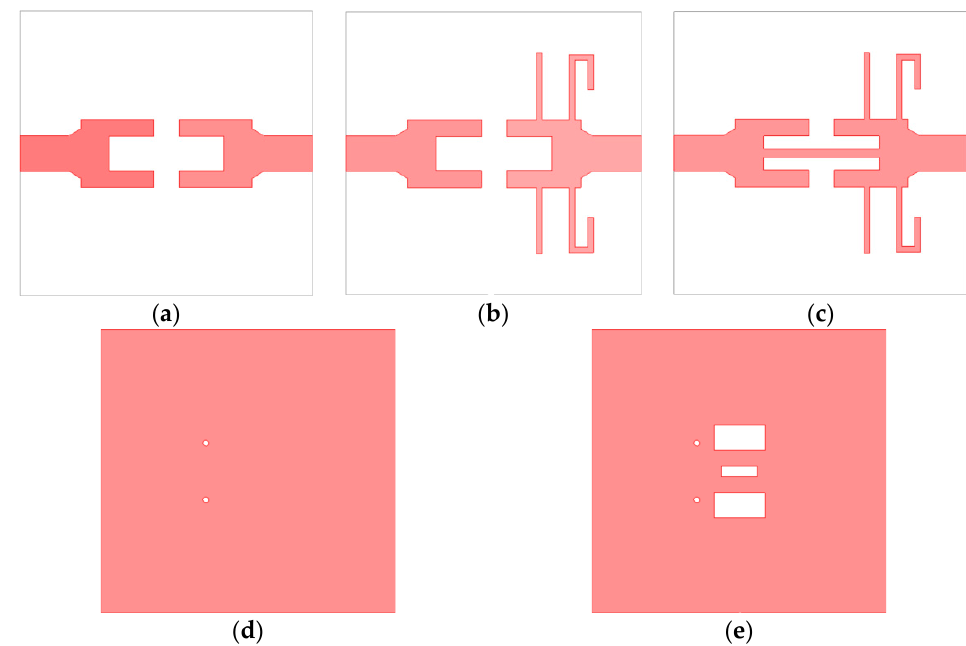
Figure 2. ( a ) Coupling pattern of two U-shaped microstrip lines; ( b ) Loading two groups of termi- nal-open stubs; ( c ) Adding central connecting microstrip line; ( d ) Ground plane with two blind holes; ( e ) Ground layer with defected structure.